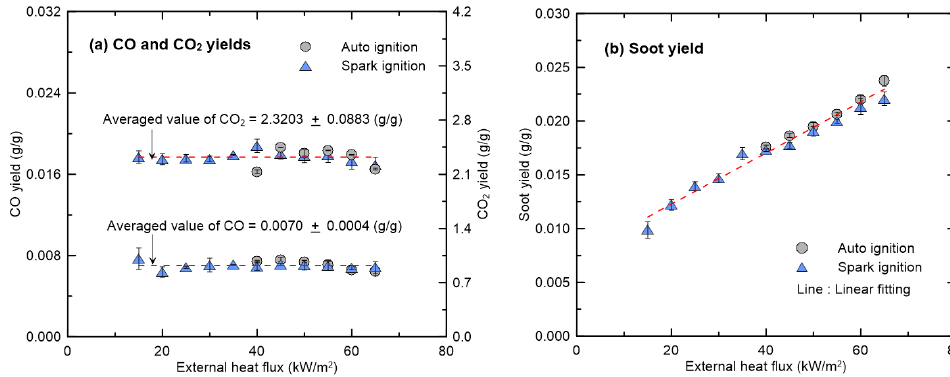
Figure 9. CO, CO 2 , and soot yields as a function of external heat flux.